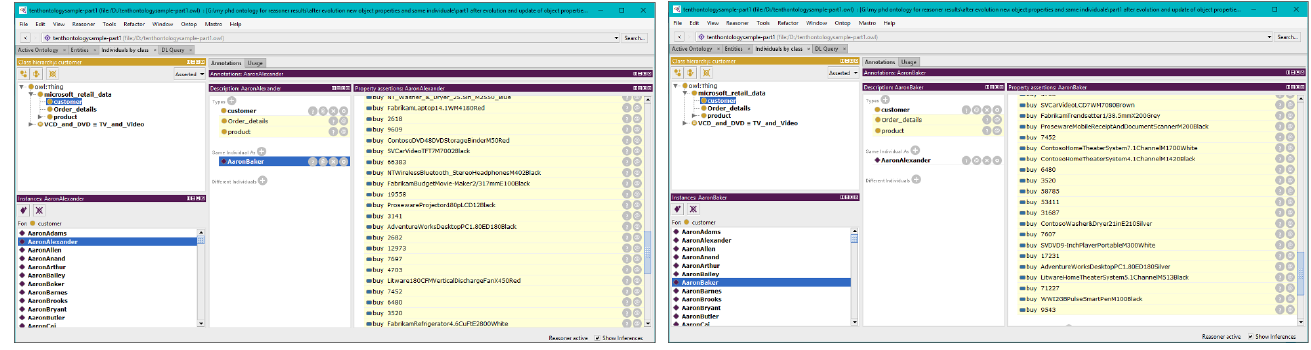
Figure 10. Reasoner results before evolution.